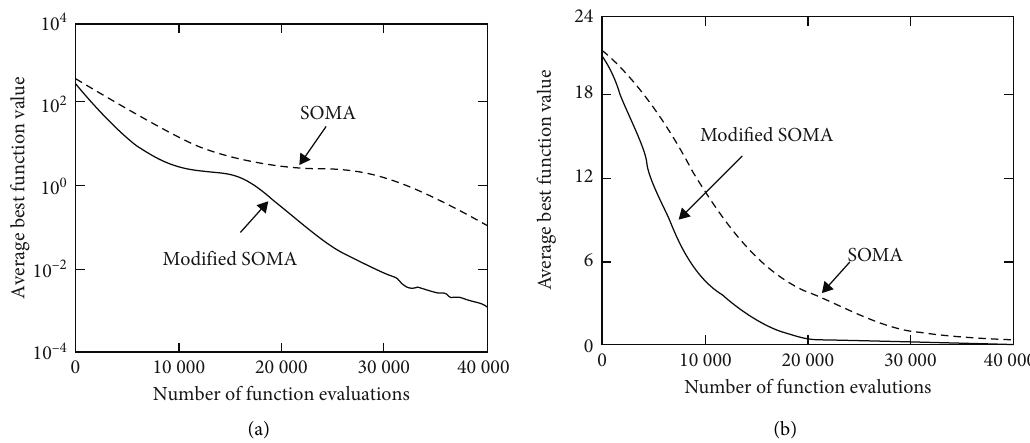
Figure 2: Convergence curves of modified SOMA and SOMA on global optimal partial coincidence